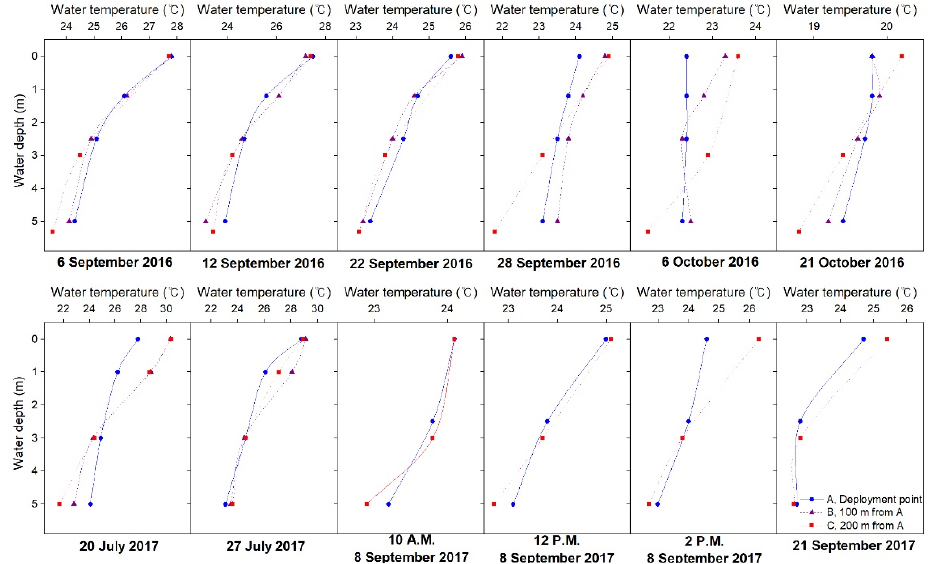
Figure 4. Vertical profiles of water temperature in the 2016 and 2017 seasons. A—The CWCS deployment site (site A), B—100 m away from the deployment site (site B), and C—200 m away from the deployment site (site C).